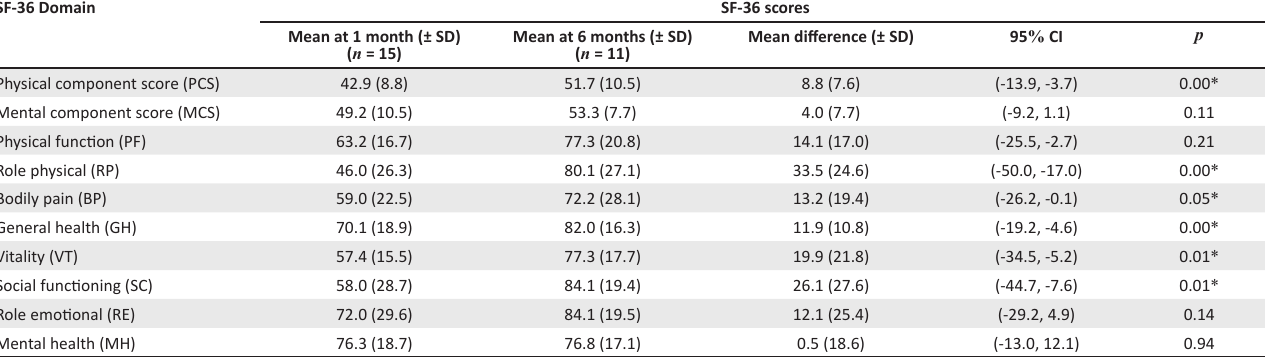
TABLE 4: Mean SF-36 domain and summary scores for participants obtained at 1 month and 6 months after discharge. SF-36 Domain